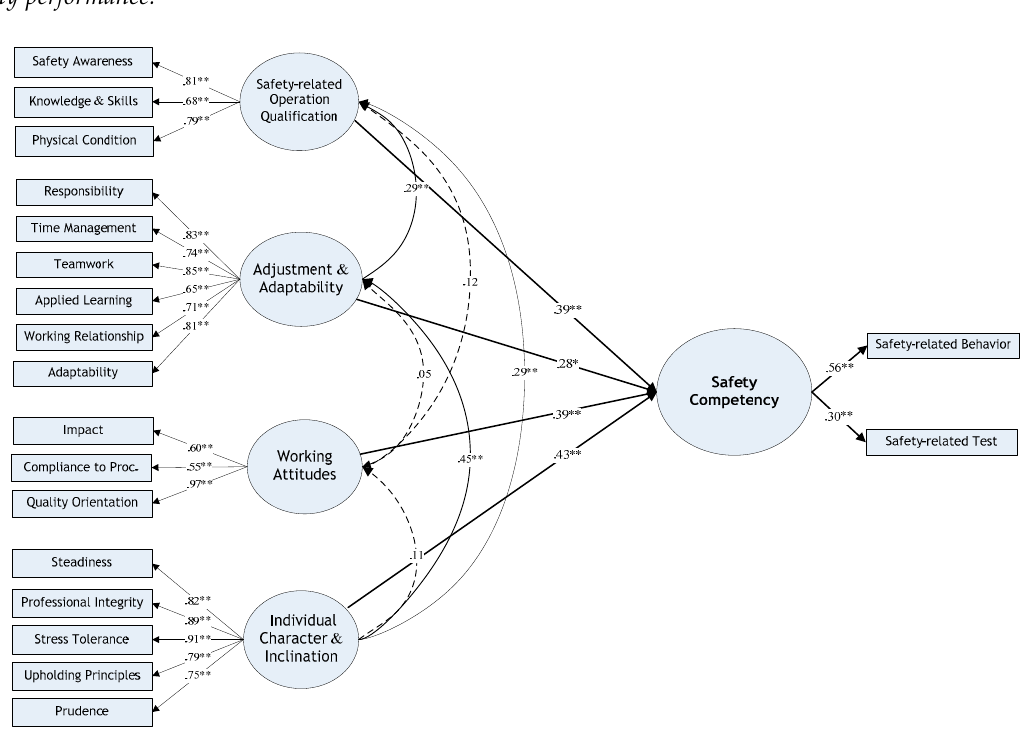
Table 12. Direct, indirect, and total effects of latent factors.